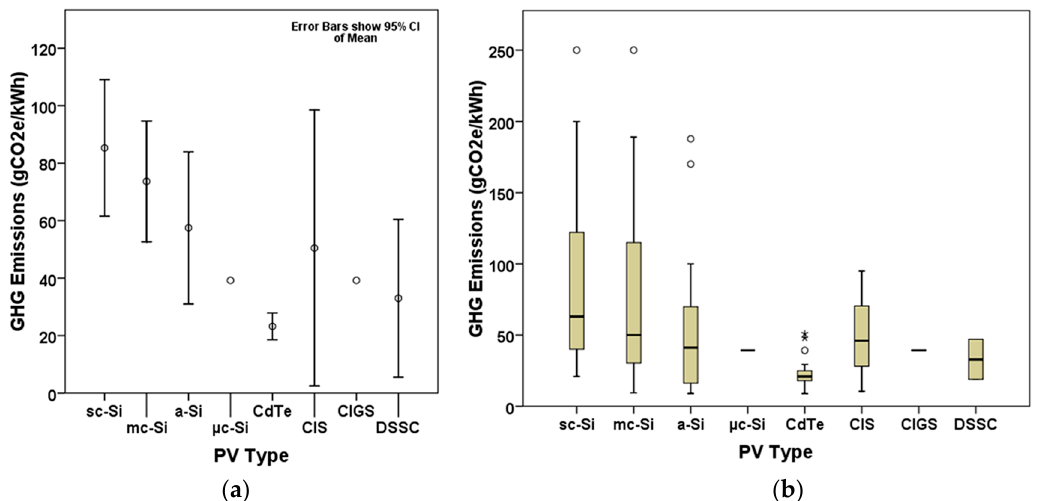
Figure 1. GHG emissions from PV electricity generation systems: ( a ) mean ± 95% CI error bars and ( b ) quartile box plots. Table 3. GHG emission (gCO 2 e/kWh) statistics from PV electricity generation systems.